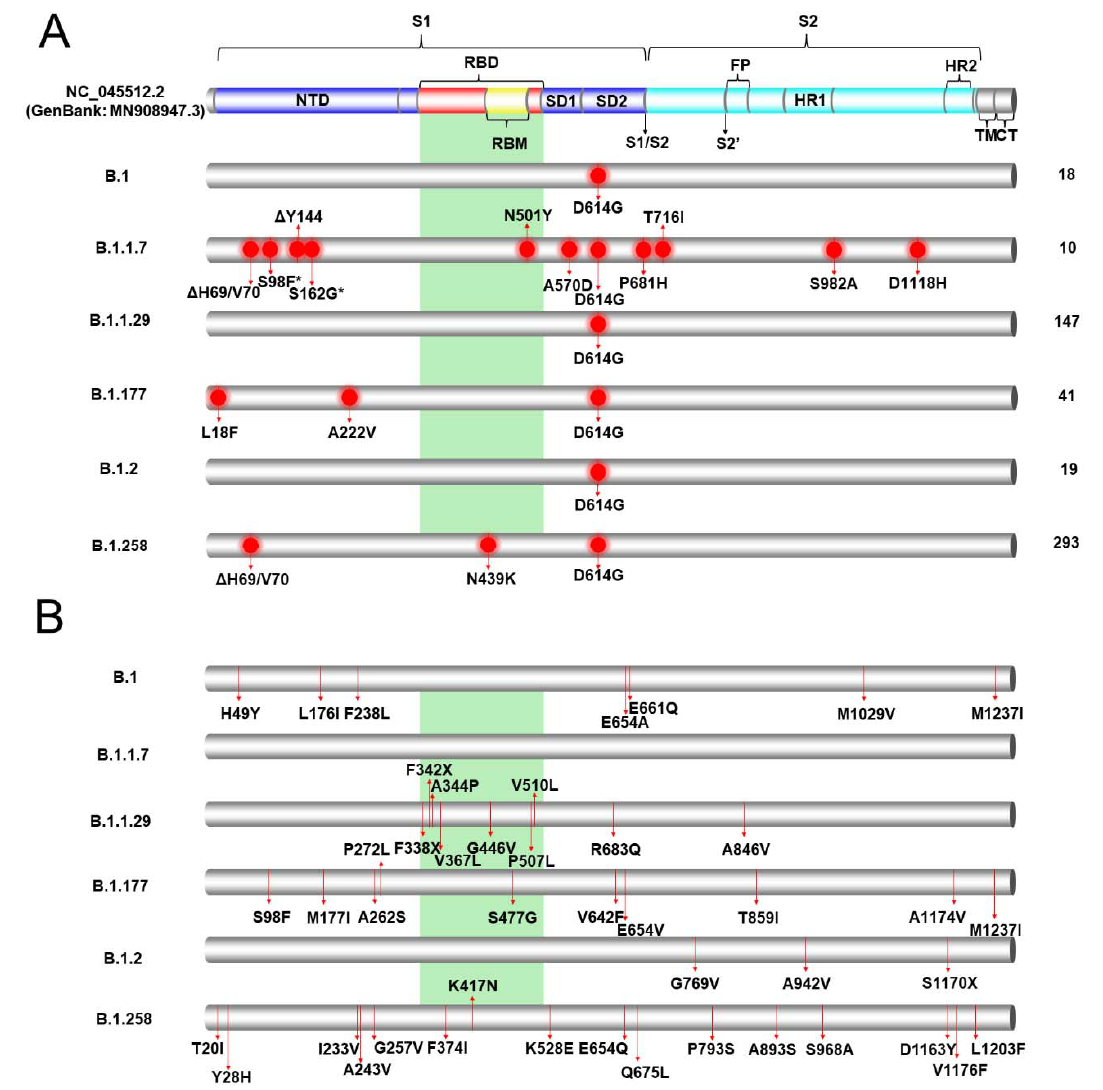
Figure 2. 3D schematic model of the SARS-CoV-2 S protein showing the locations of common mutations/deletions in the most prevalent lineages (B.1.258, B.1.1.29, B.1.177, B.1.2, B.1 and B.1.1.7) in Cyprus. The model was produced by PyMol (Version 2.4.1, Schrödinger, LLC, https://www.pymol.org, accessed on 18 February 2021) and is based on data derived and adapted from Protein Data Bank entry 6XEY [49]. On the left side, the S protein trimer is shown as a transparent surface representation (transparency 0.5), but the S protein monomer is not transparent. On the upper-left side of the figure, the top of the protein is depicted, and on the lower-left side, the S protein has been rotated at a 90-degree angle to show the side view. On the right side of the figure, the S protein monomer is depicted in the upper right showing the top view, and the lower right side shows the side view of the monomer. Circles and arrows indicate the approximate locations of the common S-protein mutations/deletions identified in the most prevalent lineages (B.1.258, B.1.1.29, B.1.177, B.1.2, B.1 and B.1.1.7) in Cyprus in this study. White circles represent mutations/deletions on the outer surface, while open circles represent mutations within the protein or on the backside of the protein. Asterisks represent mutations/deletions that were found in approximately half of the sequences in the B.1.1.7 lineage; S98F was found in 5/10 sequences, and S162G was found in 4/10 sequences. The colored domains are RBDs. RBD, receptor-binding domain (red); RBM, receptor-binding motif (yellow); SD1, subdomain 1; SD2, subdomain 2; FP, fusion peptide; S1, subunit 1 (blue); S2, subunit 2 (cyan). Since this field is still under global scientific investigation, a number of published sources, including the UniProt entry P0DTC2, were used to identify each domain along with their start and end locations